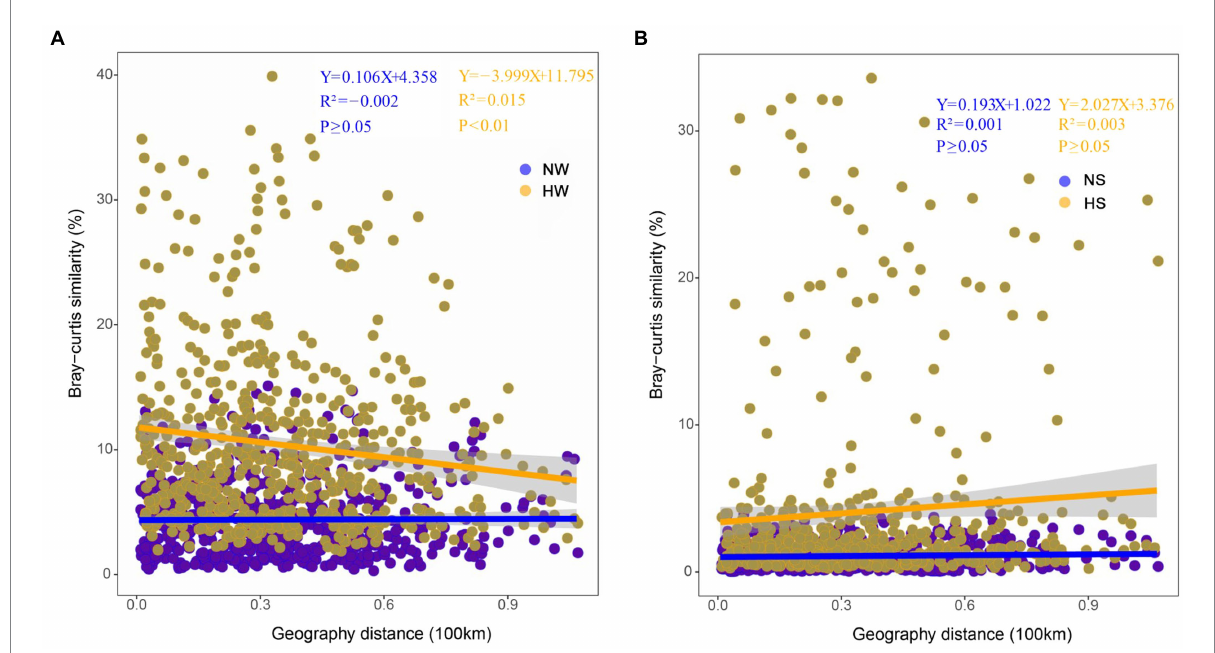
FIGURE 5 Distance-decay patterns based on the Bray–Curtis similarity of bacterial community composition and cumulative dendritic distance in different periods. (A) Comparison of planktonic bacterial community between the two periods. NW, water in the normal period; HW, water in the high-water period. (B) Comparison of sedimentary bacterial community between the two periods. NS, sediment in the normal period; HS, sediment in the high-water period.